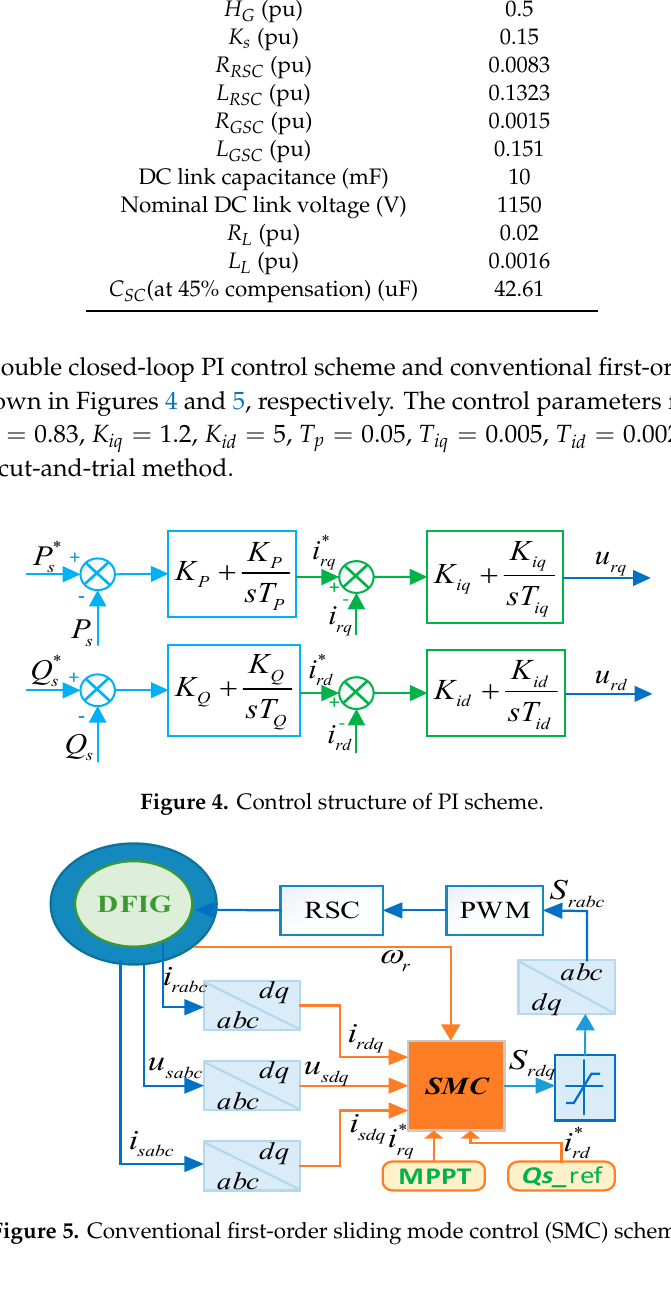
Figure 6. Responses of active power, reactive power, electromagnetic torque, DC link voltage with no series ‐ compensated capacitors. Next, let us evaluate control performance under different series ‐ compensated levels. Under the wind speed of 7 m/s, a series compensation of 40% is added at t = 1 s. The responses of active power, reactive power, electromagnetic torque, DC link voltage, stator current and rotor current are shown in Figure 7. Though SSCI occurs when the series ‐ compensated capacitor is switched on, it is rapidly suppressed after 1.5 s. There is also oscillation observed in DC link voltage due to the influence of power fluctuation in converters, however, the oscillation can be rapidly suppressed, which indicates the validity of the proposed strategy for the voltage surge in DC link voltage. Stator current and rotor current are also shown in Figure 7 with a short transient time and small overshoot.